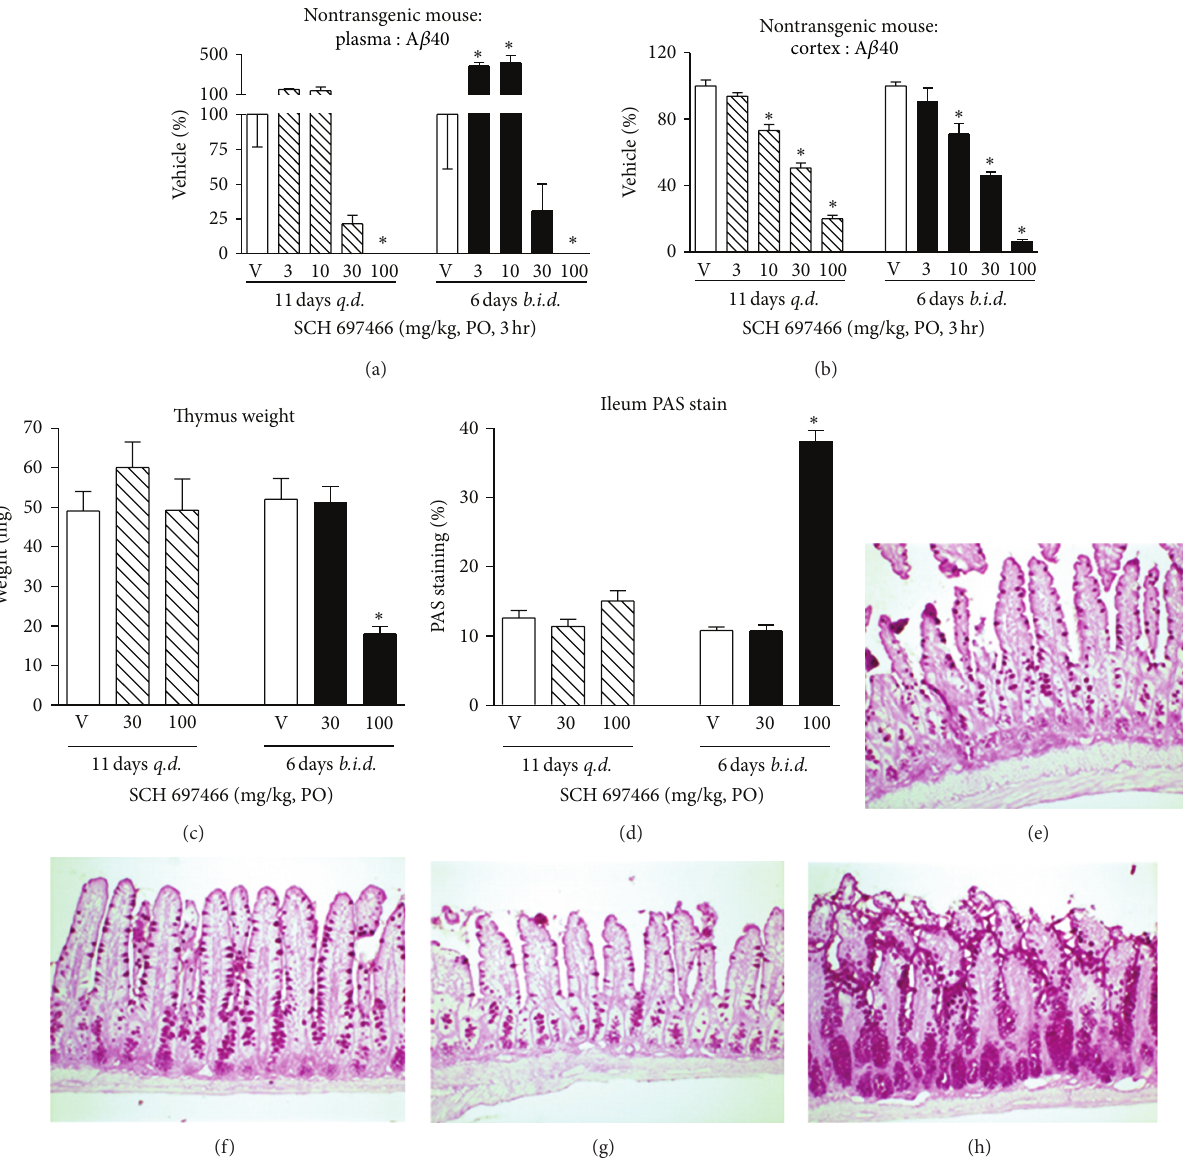
Figure 5: A 𝛽 40 levels expressed as a percent of vehicle in (a) plasma and (b) cortex, (c) thymus weight, and (d) percent area in the ileum covered by PAS stain following 11 days of q.d. administration (left side of graphs) or 6 days of b.i.d. administration (right side of graphs) of SCH 697466 in nontransgenic B6C3F1 mice. The final dose of SCH 697466 was given 3 hr prior to tissue harvesting. Representative examples of the PAS stained ileum from (e) 11 day q.d. vehicle-treated mouse; 13% PAS staining, (f) 11 day q.d. 100 mg/kg SCH 697466 treated mouse; 16% PAS staining, (g) 6 day b.i.d. vehicle-treated mouse; 11% PAS staining, and (h) 6 day b.i.d. 100 mg/kg SCH 697466 treated mouse; 39% PAS staining. Increased PAS staining was only observed in the 6 day b.i.d. 100 mg/kg treated group. ∗ 𝑃 < 0.003 versus vehicle, Dunnett post hoc